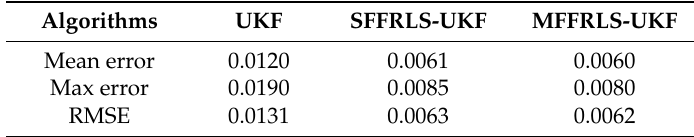
Table 7. Statistic characters of SOC estimation of constant temperature NEDC test.